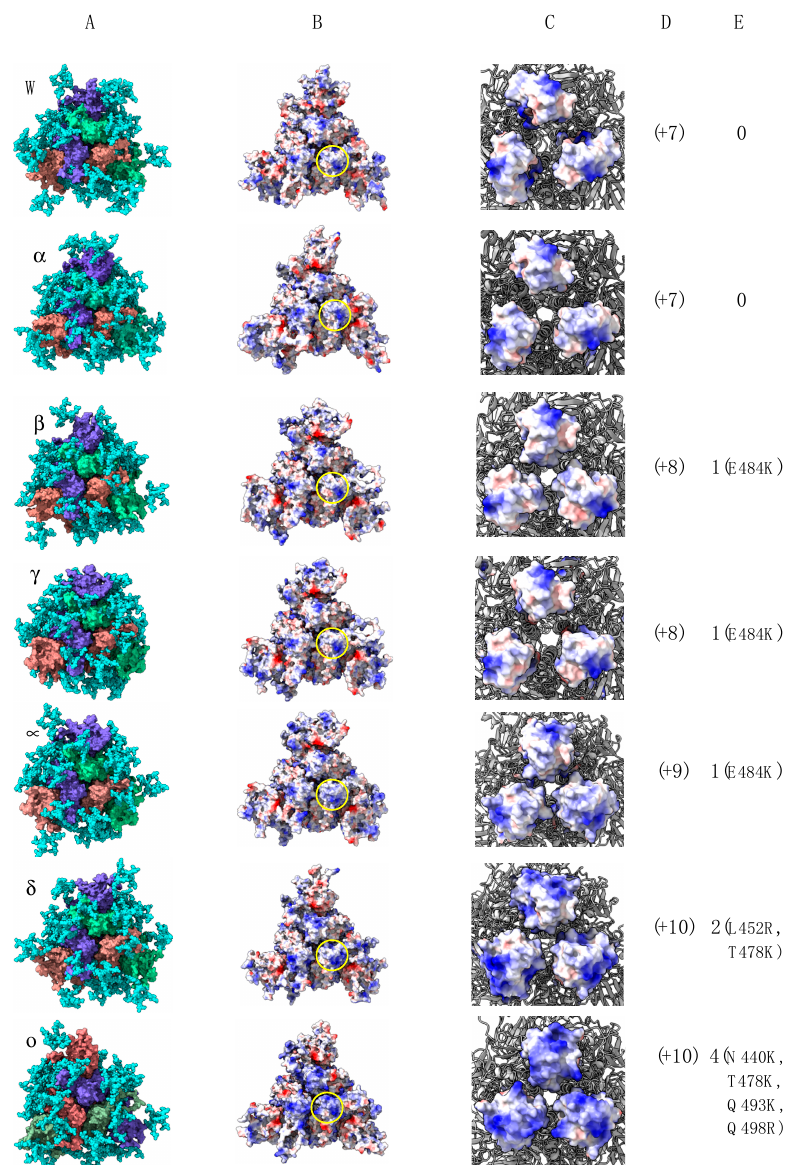
(o) variant (Figure 2B,C). Accordingly, the net charges and p I (isolelectric point) values calculated for the variants increase in the kappa, delta and omicron variants (Figure 2D,E).